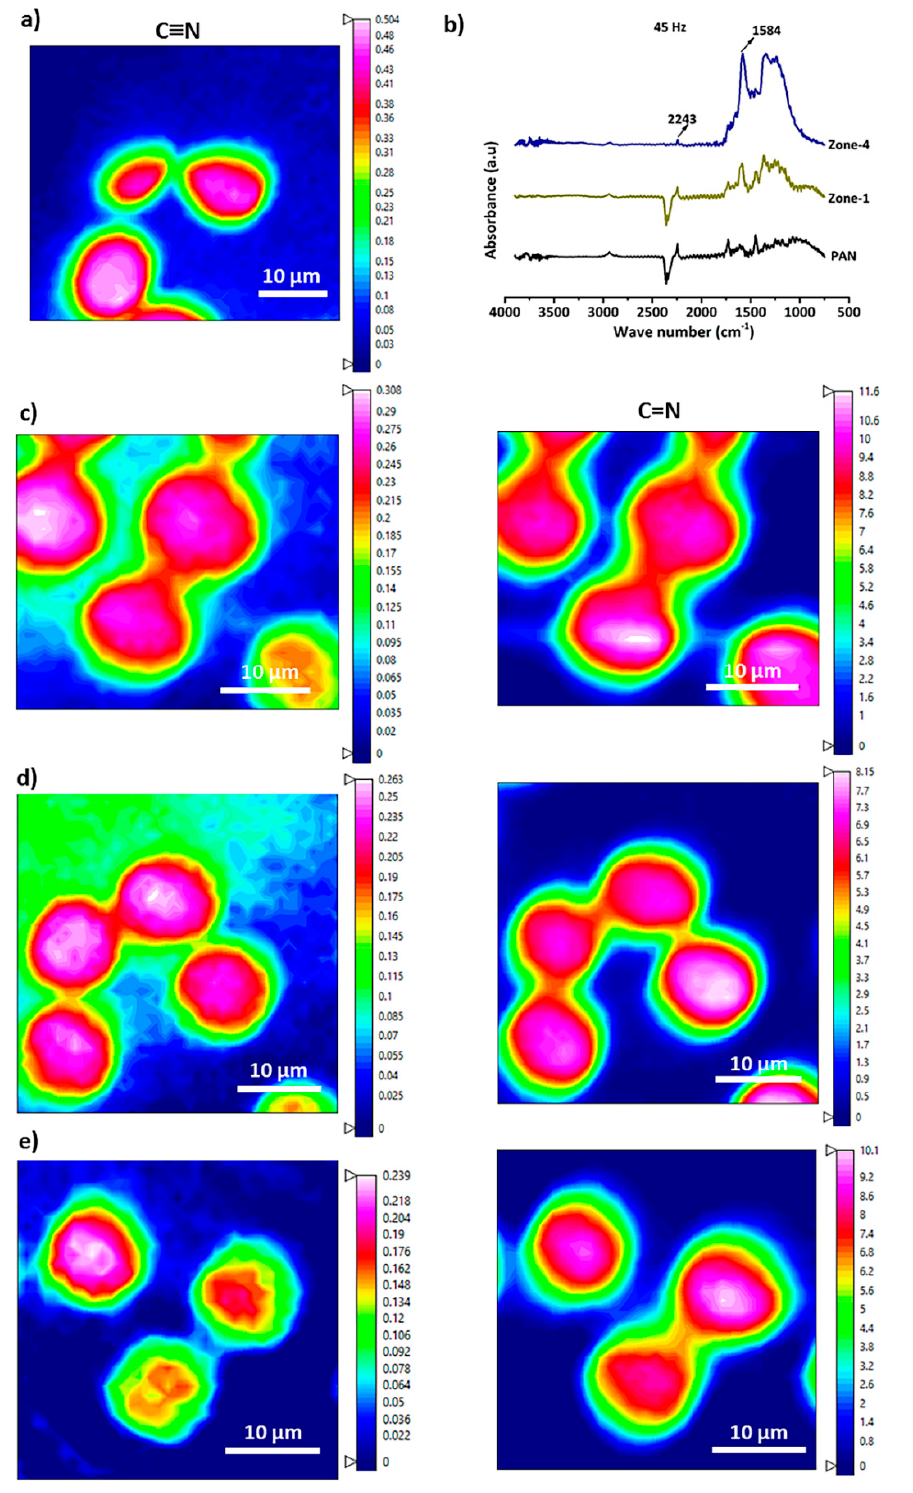
Figure 3. Distribution of nitrile (C ≡ N) and C=N functional groups in the fiber cross-sections of PAN and Zone-4 samples with respect to fan frequencies. ( a ) PAN, ( b ) FTIR spectra, ( c ) 35 Hz, ( d ) 45 Hz, and ( e ) 60 Hz. (Note: the left column indicates C ≡ N distribution and the right column indicates C=N distribution in thermally treated fibers).